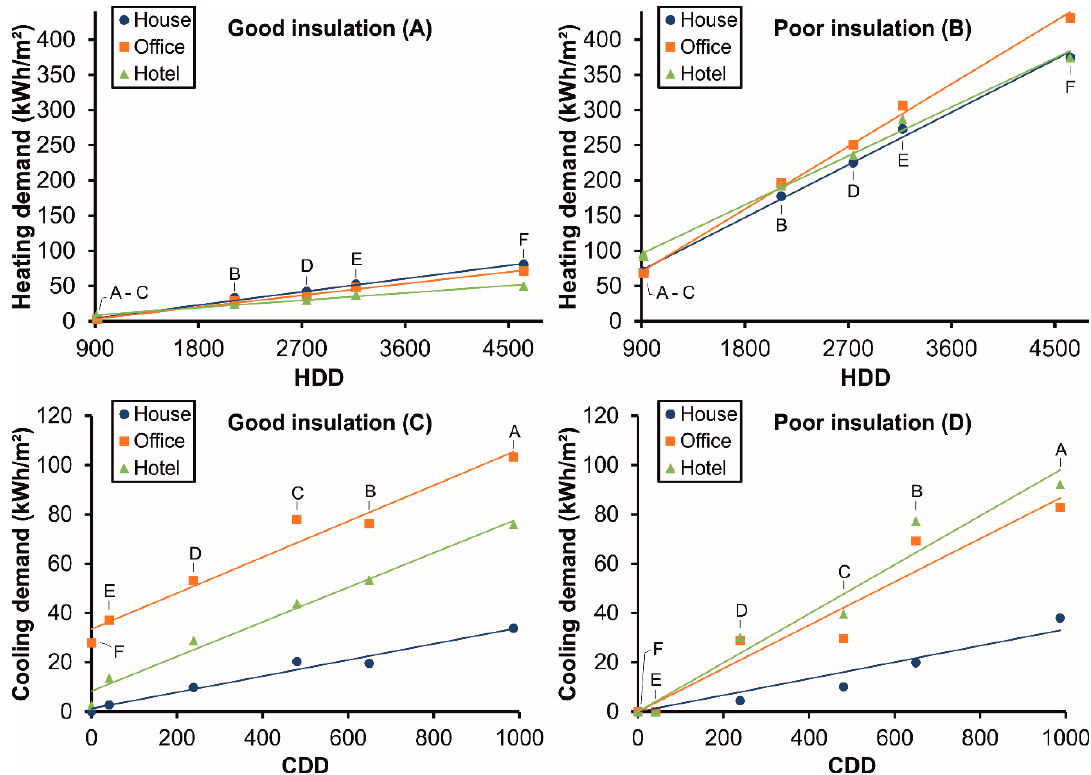
Figure 5. Heating signature for well-insulated ( A ) and poorly-insulated ( B ) buildings; cooling signature for the well-insulated ( C ) and poorly-insulated ( D ) buildings.